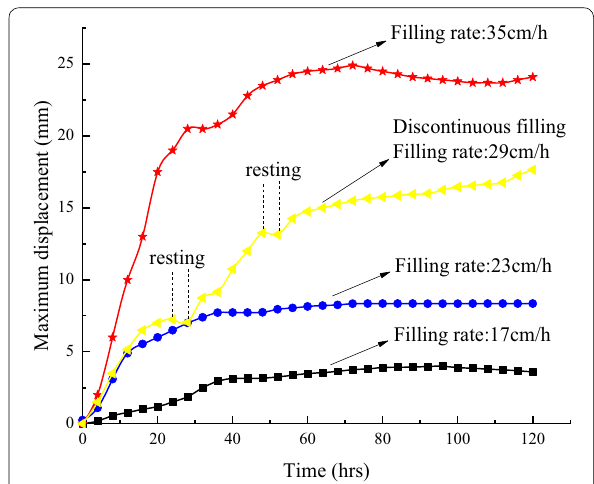
Fig. 16 Influence of filling strategy on the barricade displacement versus